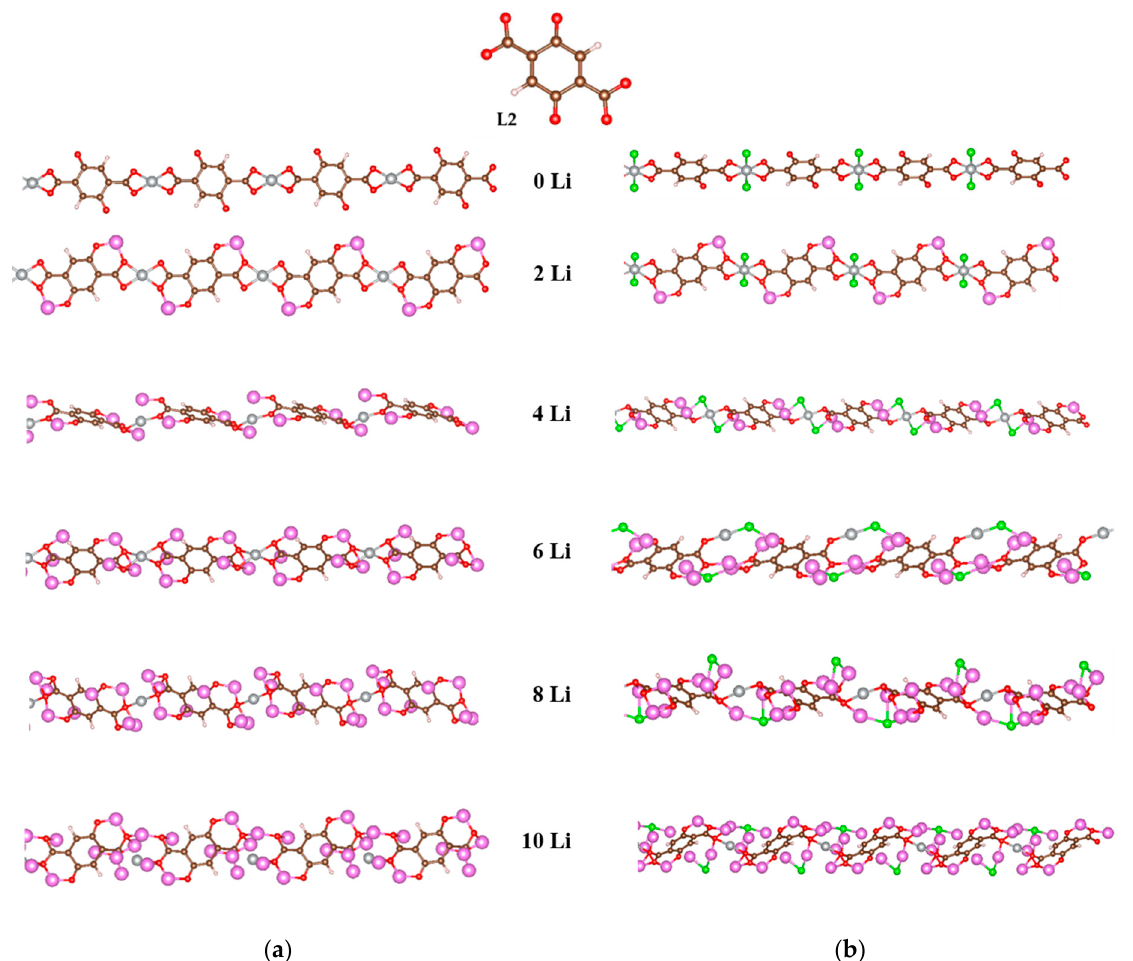
Figure 7. Optimized geometries of the step-by-step lithiated coordination polymers of ( a ) Ni(II) and ( b ) Ni(IV) with 2,5-dicarboxylato-1,4-quinone (L2). Color code: C—brown, H—white, O—red, Ni –gray, Cl—green, Li—pink.